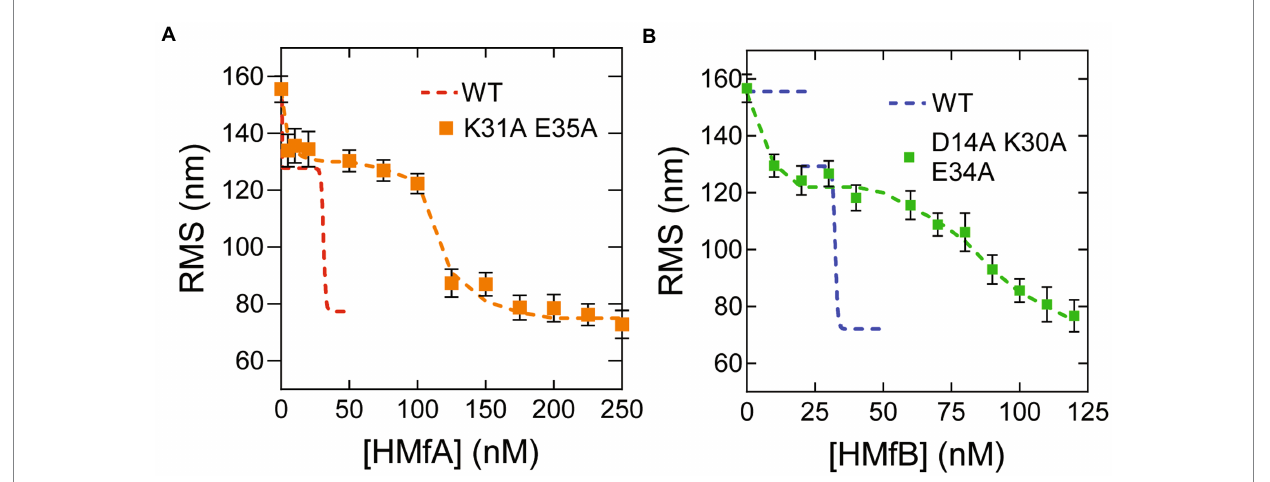
FIGURE 2 Histone derivatives HMfAK31A E35A and HMfBD14A K30A E34A recognize the Clone20 sequence. (A) Root mean square displacement (RMS) values of Clone20 DNA tethers with HMfA K31A E35A or (B) HMfB D14A K30A E34A as measured by TPM in 50 mM Tris–HCl pH 7, 75 mM KCl. Wildtype data was reproduced from Figure 1. Histograms were fitted to a Gaussian distribution. Error bars represent the propagated standard deviation of at least two replicates. Dashed lines are to guide the eye.